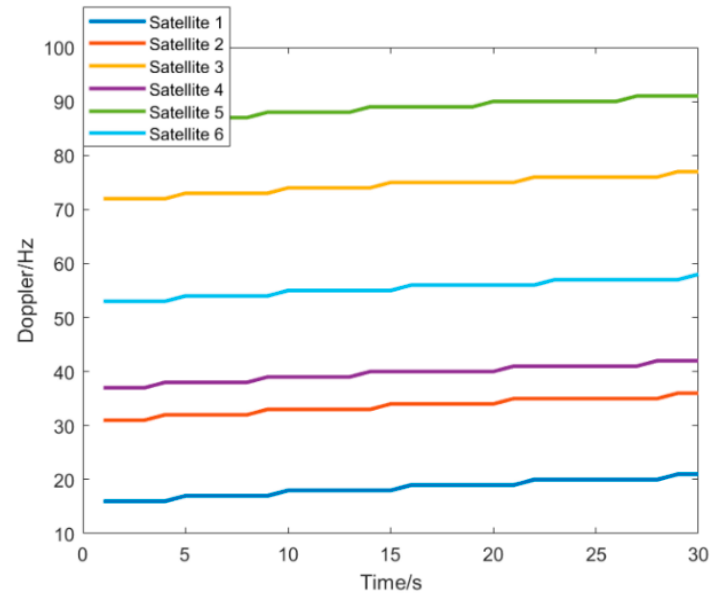
Figure 5. Bistatic range versus the slow time. The bistatic Doppler can also be obtained by the RD map by taking the peak of the target echo. Figure 6 shows the bistatic Doppler variation curve versus time for different satellites. It can be seen from the figure that the Doppler changed uniformly with slow time for the different satellites. Compared with bistatic ranges, the variation of Doppler with time was much more obvious. At the same time, due to the different bistatic structure, the Doppler corresponding to the target under different illumination sources was quite different.